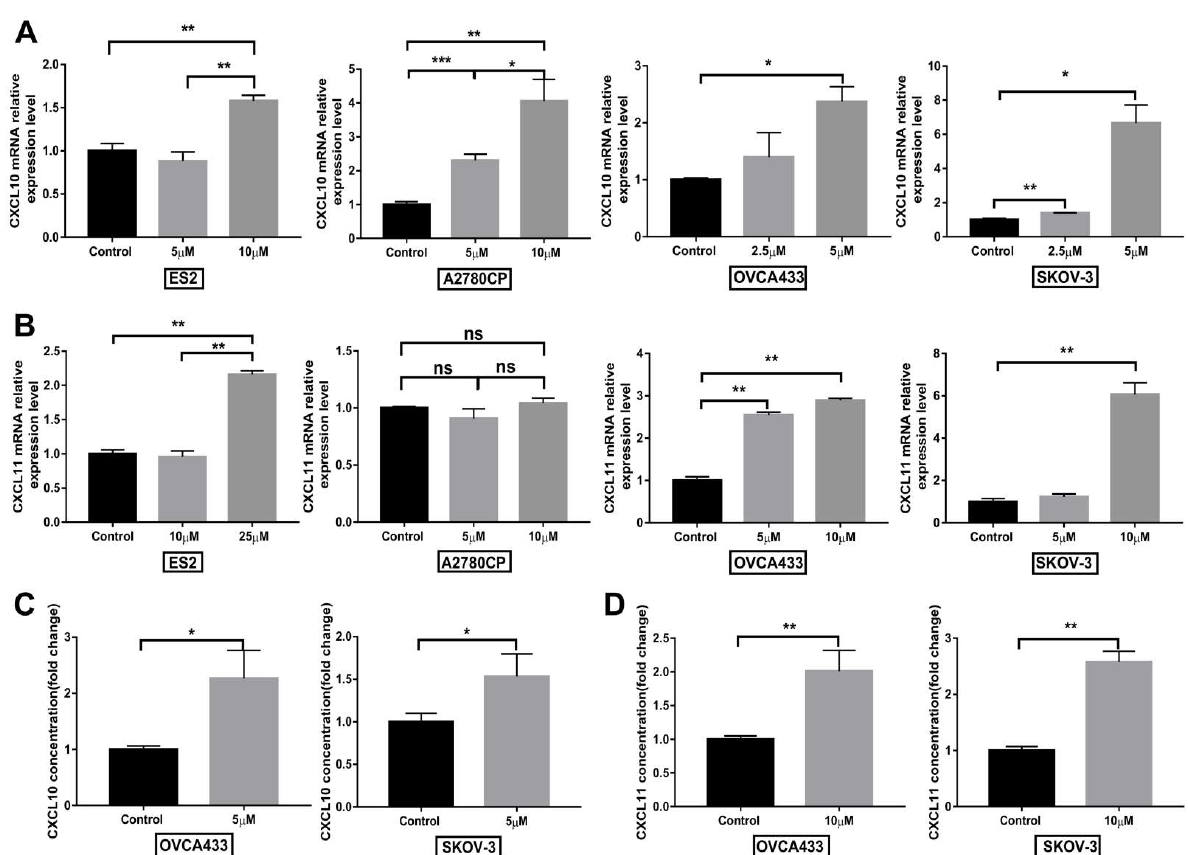
Figure 7. Compound 968 treatment increased CXCL10 and CXCL11 secretion by cancer cells. The human ovarian cancer cells (ES2, A2780CP, OVCA433 or SKOV-3) were treated with different doses of 968 for 48 h and q–PCR was used to determine CXCL10 ( A ) and CXCL11 ( B ) expression, ELISA was used to determine CXCL10 ( C ) and CXCL11 ( D ) secretion. Results are presented as the mean ± SD, and representative data from three experiments are shown (* p < 0.05, ** p < 0.01, *** p < 0.001).